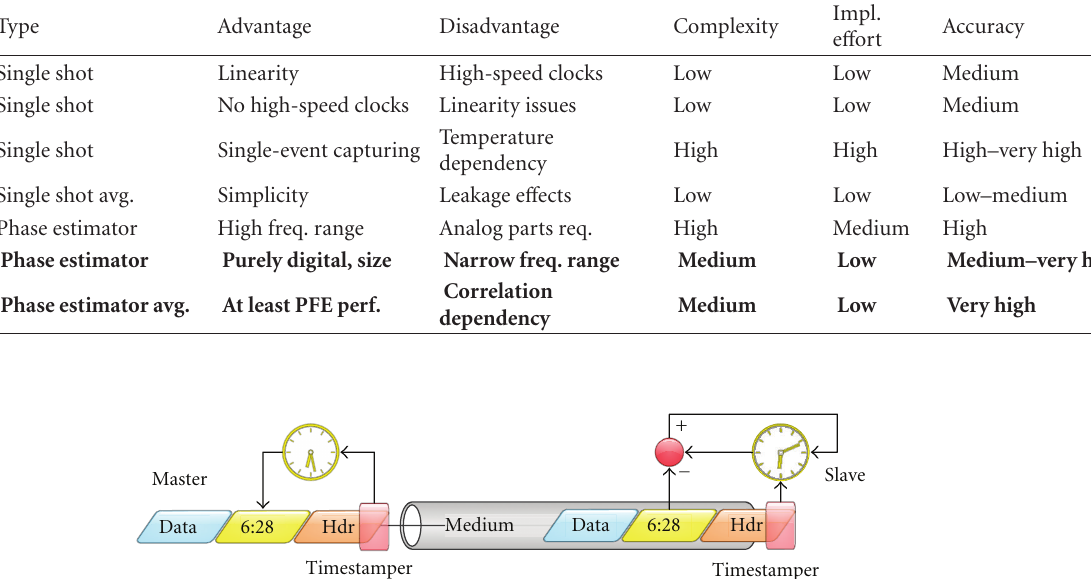
Table 1: Comparison of the di ff erent approaches.